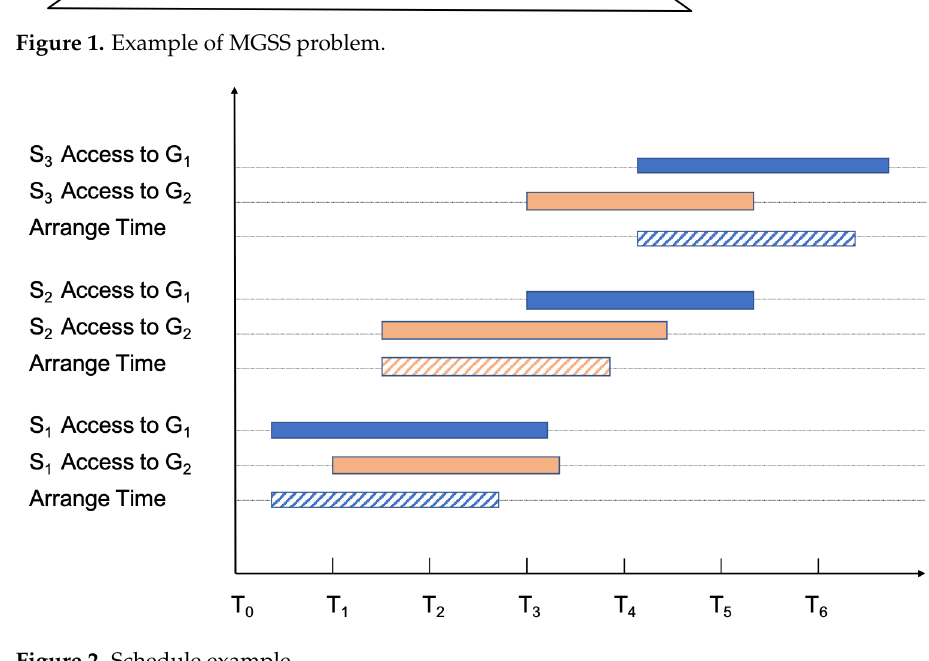
Figure 2. Schedule